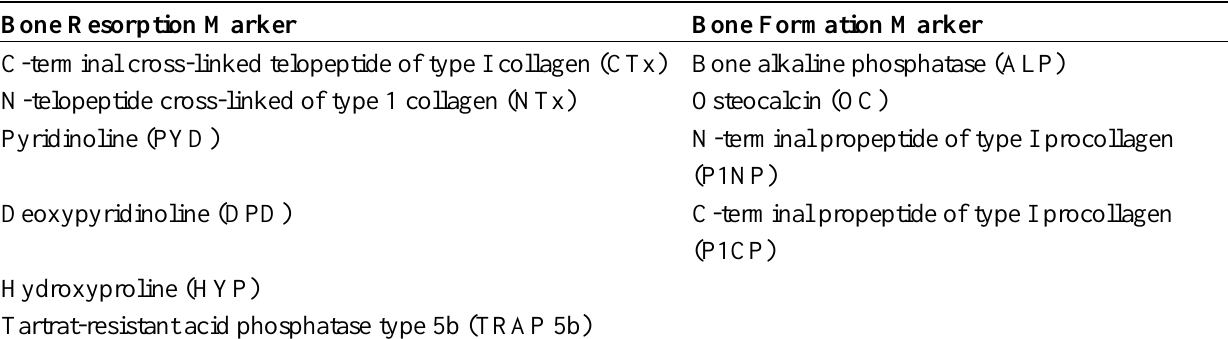
Table 2. Biochemical bone turnover markers in serum and